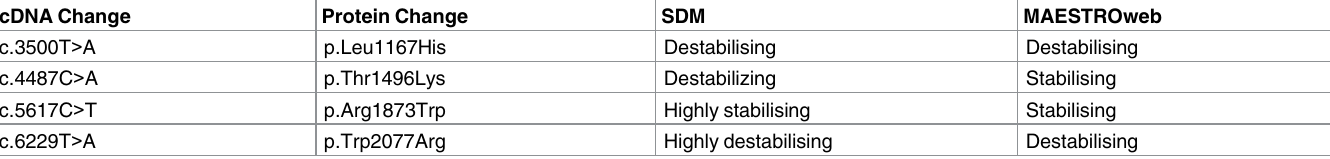
Table 3. Mutation effects on MYO7A 3D structure